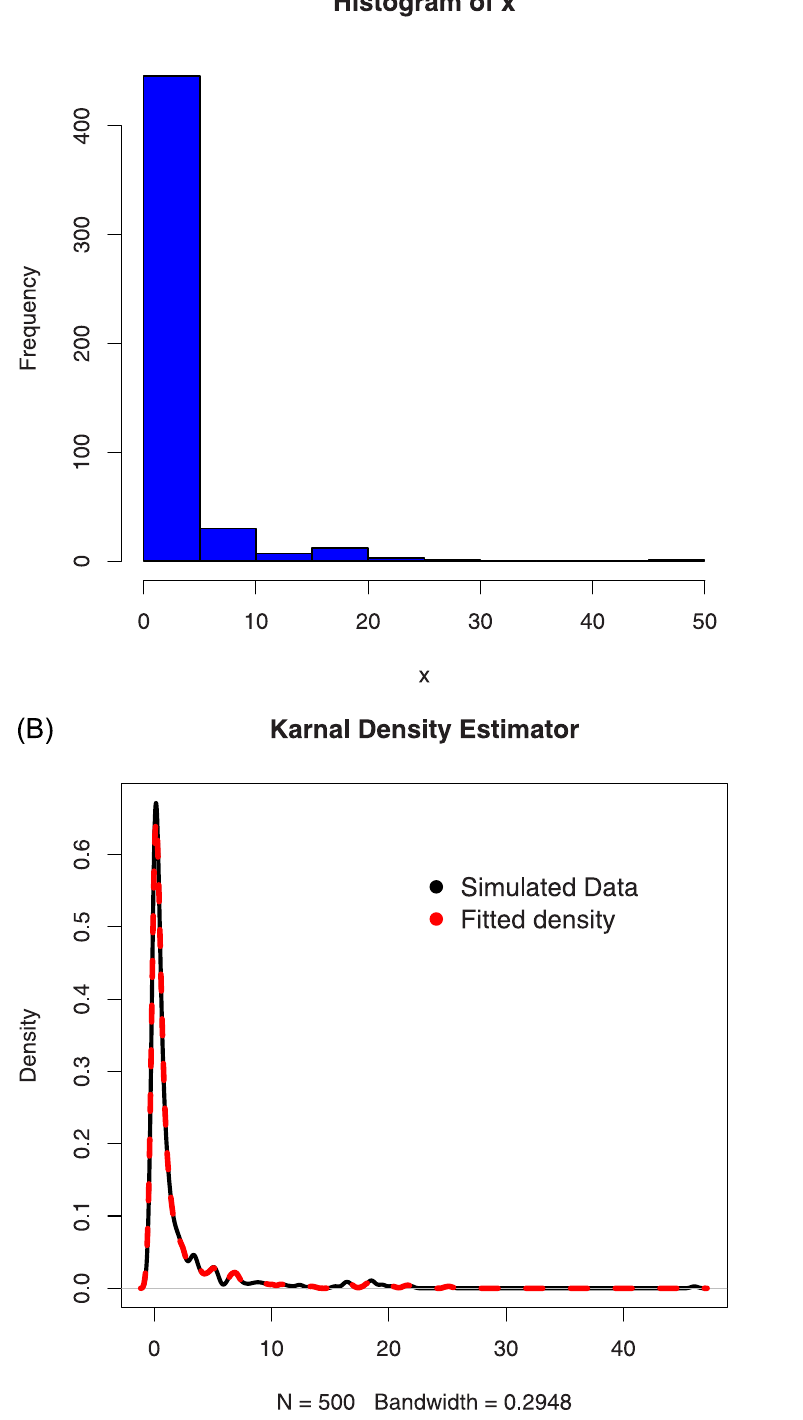
Fig 10. The histogram and Kernel density estimator of the simulated data set 2.